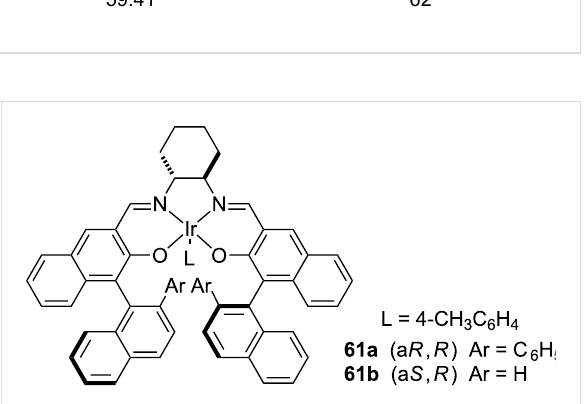
Figure 5: Iridium catalysts used by Suematsu and Katsuki for carbenoid insertion into C(sp 3 )–H